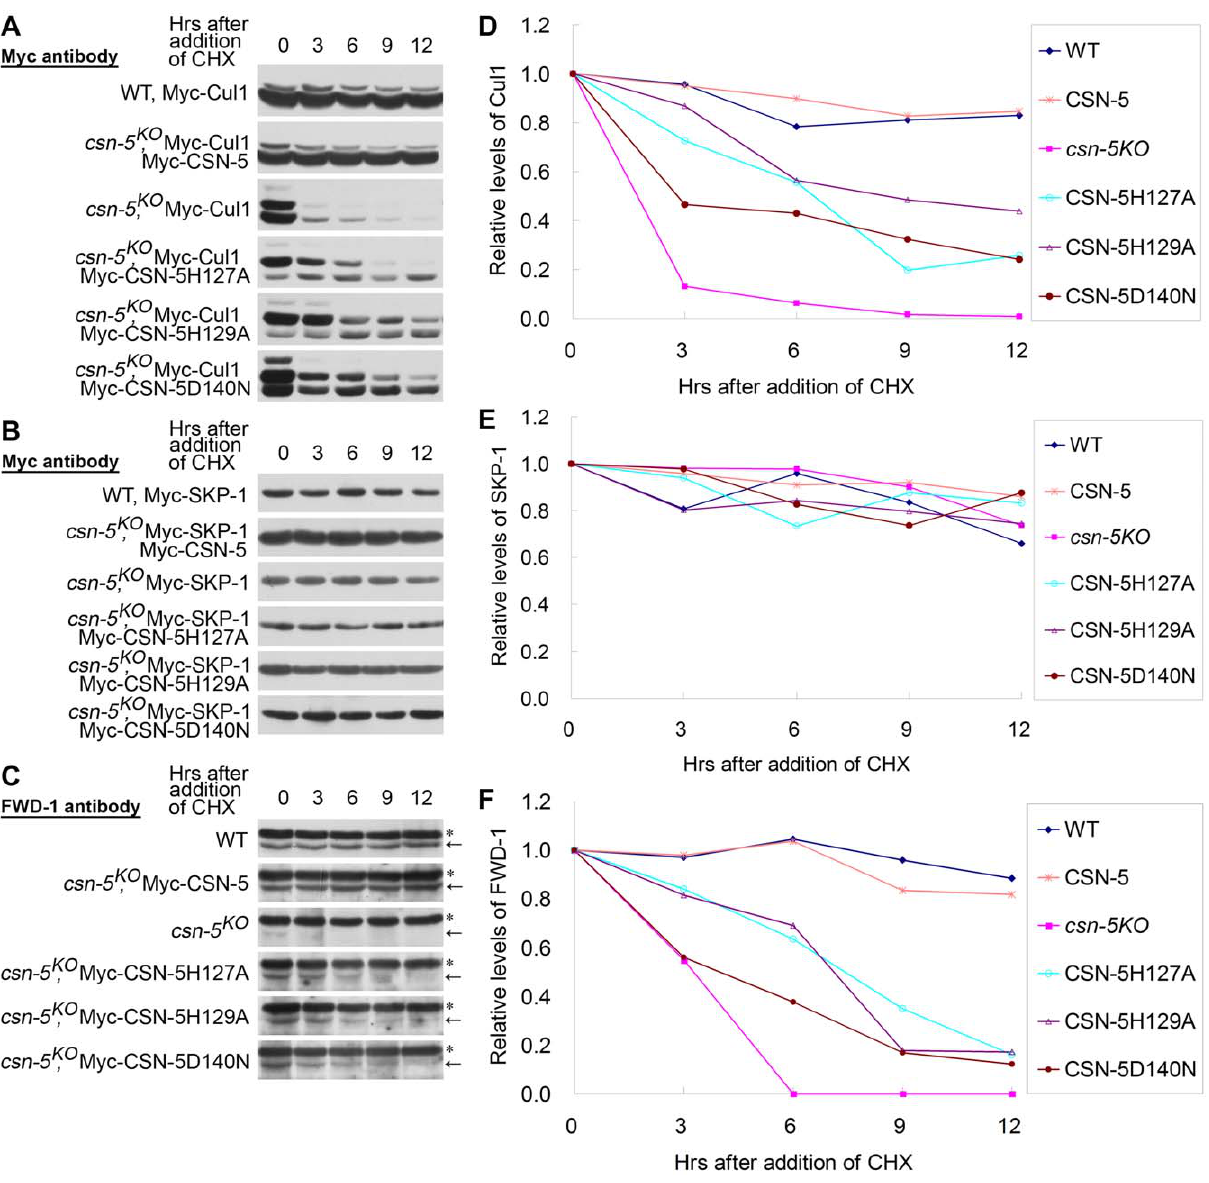
Figure 5. CSN-5–mutated CSN efficiently prevents degradation of components of the SCF FWD-1 complex. (A–C) Western blot analyses with labeled antibodies showing degradation of Myc-Cul1 (A), Myc-SKP-1 (B), and FWD-1 (C) after addition of cycloheximide (10 mg/mL) in the wild- type, csn-5 KO , and different CSN-5 complementation strains. Arrows point out FWD-1 protein bands. Asterisks indicate nonspecific bands detected by FWD-1 antibody. (D–F) Densitometric analyses from four independent experiments showing the degradation of Myc-Cul1 (D), Myc-SKP-1 (E), and FWD-1 (F).